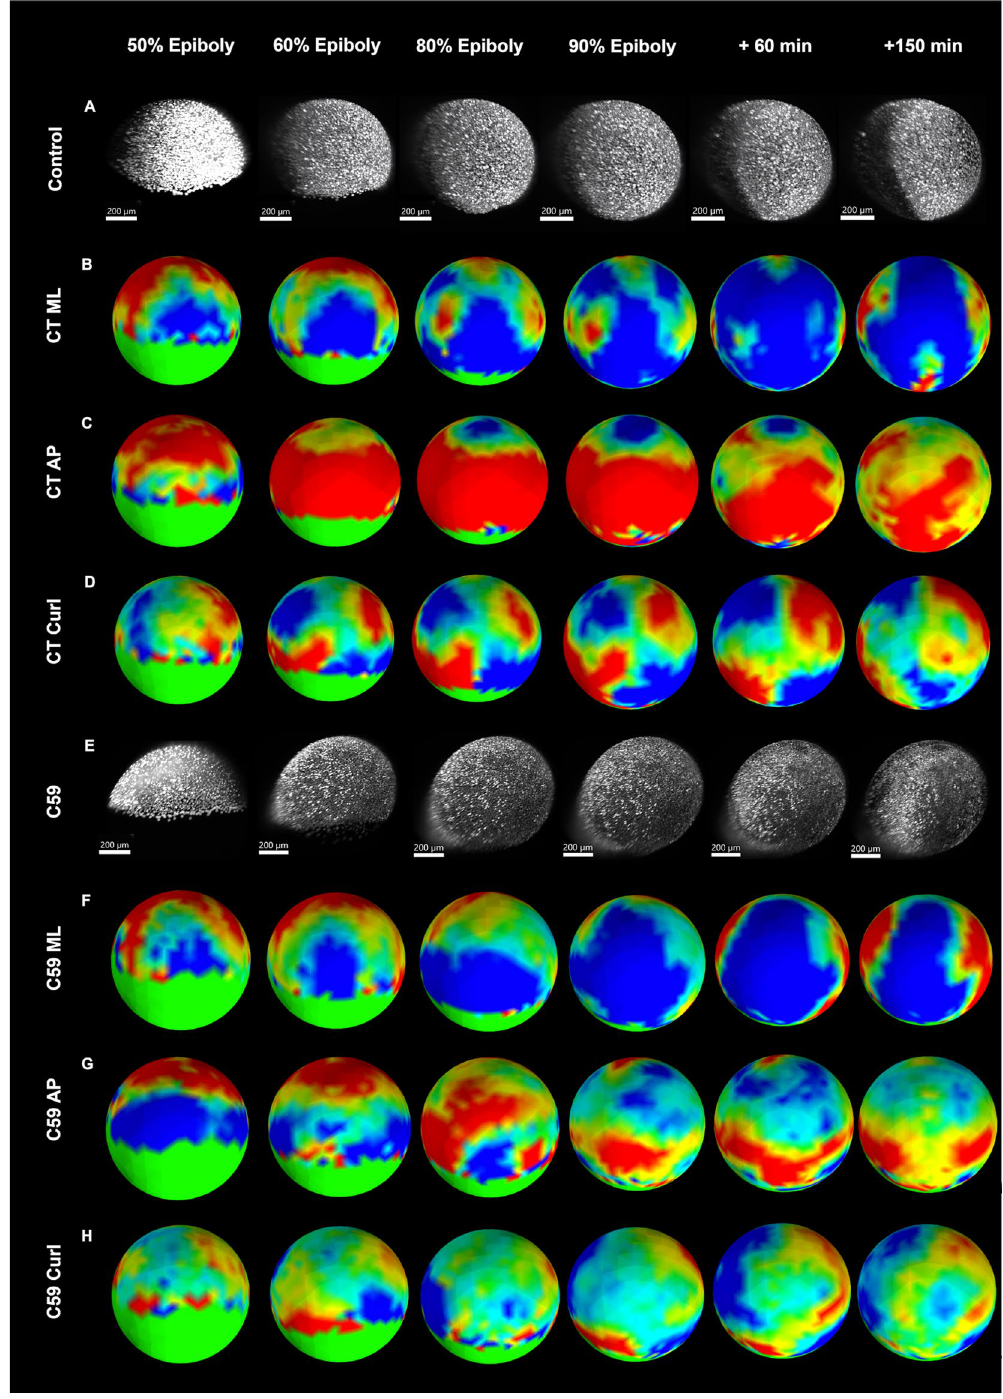
Figure 7. Comparison of the strain map between control and C59 inhibited groups (dorsal view). ( A ) Maximum Intensity Projection (MIP) of the embryo in control group at different epiboly stages; ( B ) M-L strain of the control group; ( C ) A-P strain of the control group; ( D ) Curl of the control group; ( E ) MIP of the embryo in C59 treated group; ( F ) M-L strain of the C59 group; ( G ) A-P strain of the C59 group; H. Curl of the C59